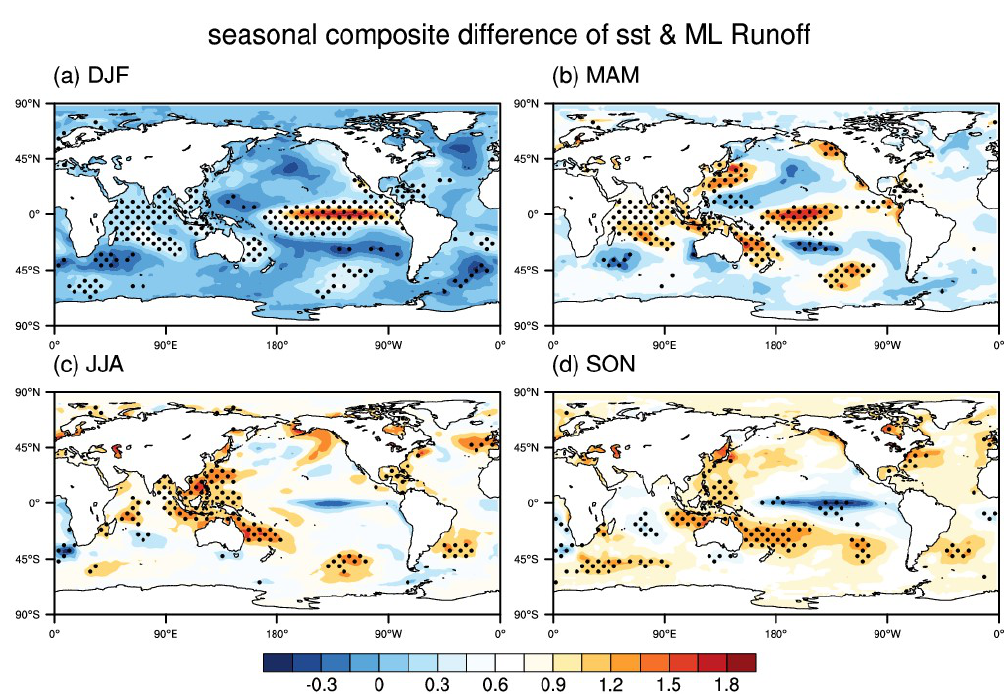
Figure 5. Same as Figure 4 but for the mid-lower May–June–July (MJJ) runoff years.